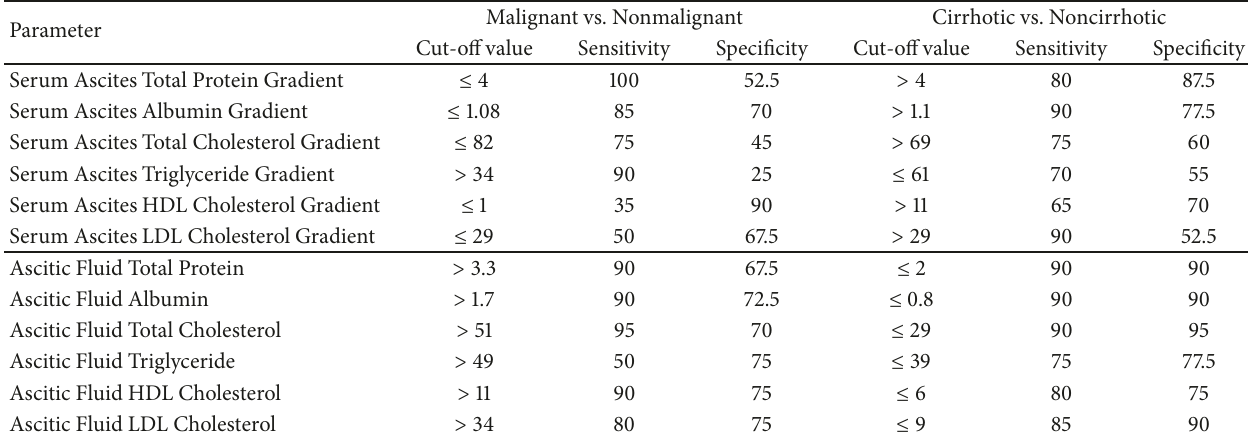
Table4:Cut-offvaluesforserumascitesgradientsandasciticfluid:Totalprotein,Albumin,TotalCholesterol,Triglycerides,HDLCholesterol, and LDL Cholesterol between Malignant vs. Nonmalignant groups and Cirrhotic vs. Noncirrhotic